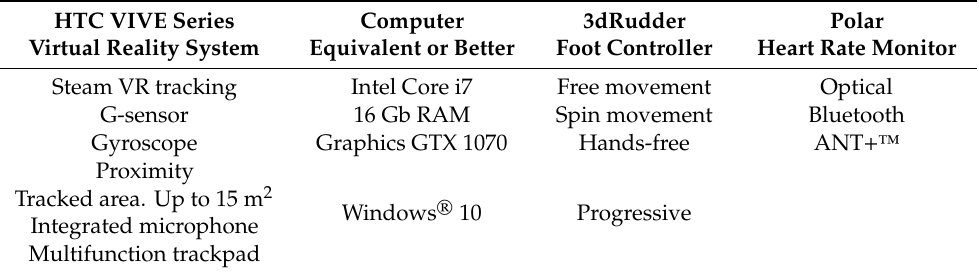
Table 2. Hardware specifications of devices used in the current study.